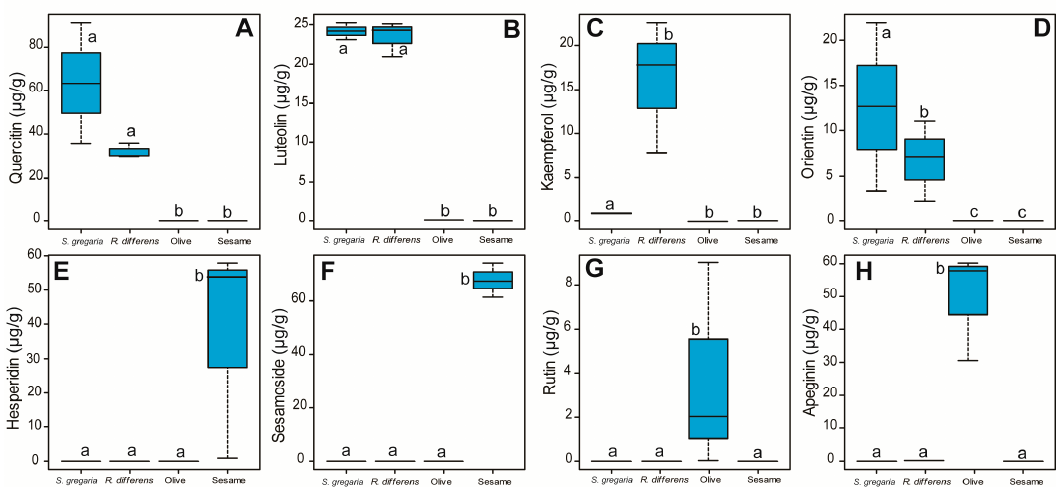
Figure 3. Flavonoid concentrations in the oils of different insect and plant species analyzed by Liquid Chromatography tandem Mass Spectrometry (LC-MS/MS). ( A ) quercetin, ( B ) luteolin, ( C ) kaempferol, ( D ) orientin, ( E ) hesperidin, ( F ) sesamoside, ( G ) rutin, and ( H ) apigenin. On each boxplot, the minimum and maximum values of all the data are represented by the ends of boxplot whiskers. Box plots with different letters are significantly different from each other (ANOVA followed by SNK’s post hoc test; p < 0.05, n = 3).